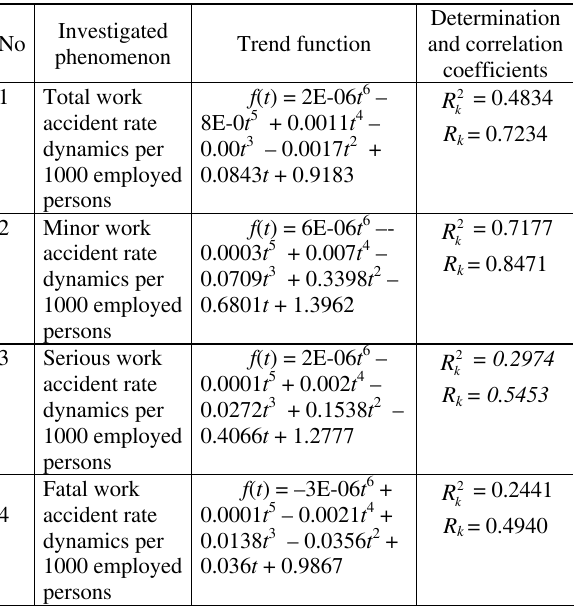
Fig 5. Serious accident rate index per construction pro- duction value of 1 M PLN in 1992–2005